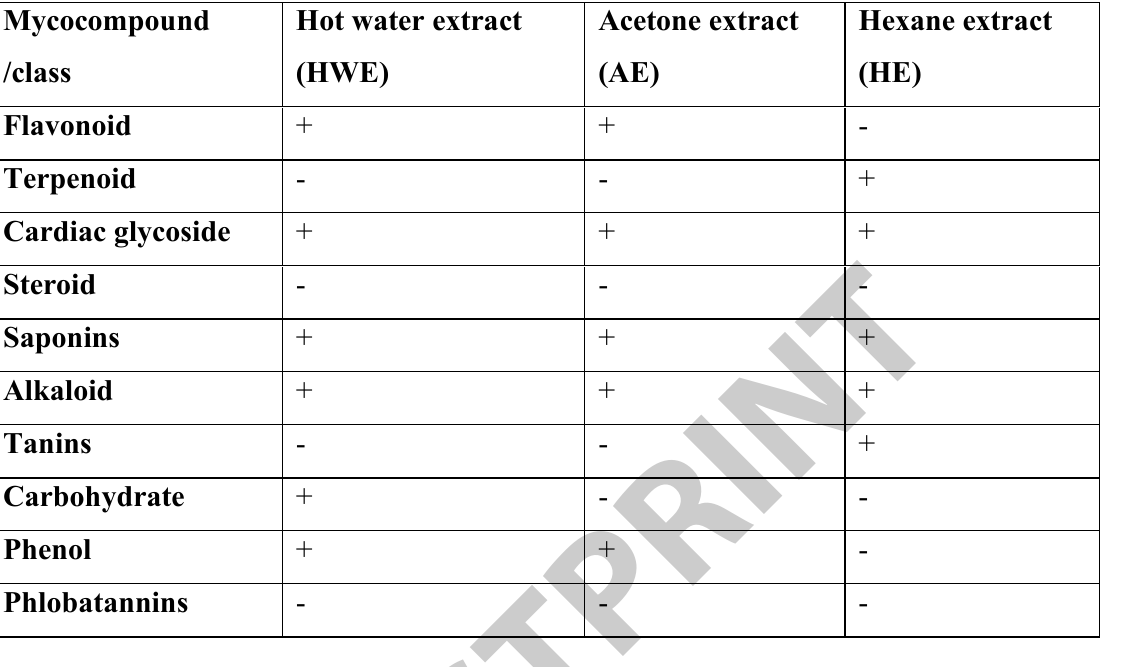
Note: Same letters in the same row indicate statistical similarity, while different letters indicate statistical difference (P=0.05) based on Duncan’s multiple test. Table 7 Mycochemical screening of the polar (water), dipolar (acetone), and nonpolar (hexane) solvent extracts of Astraeus